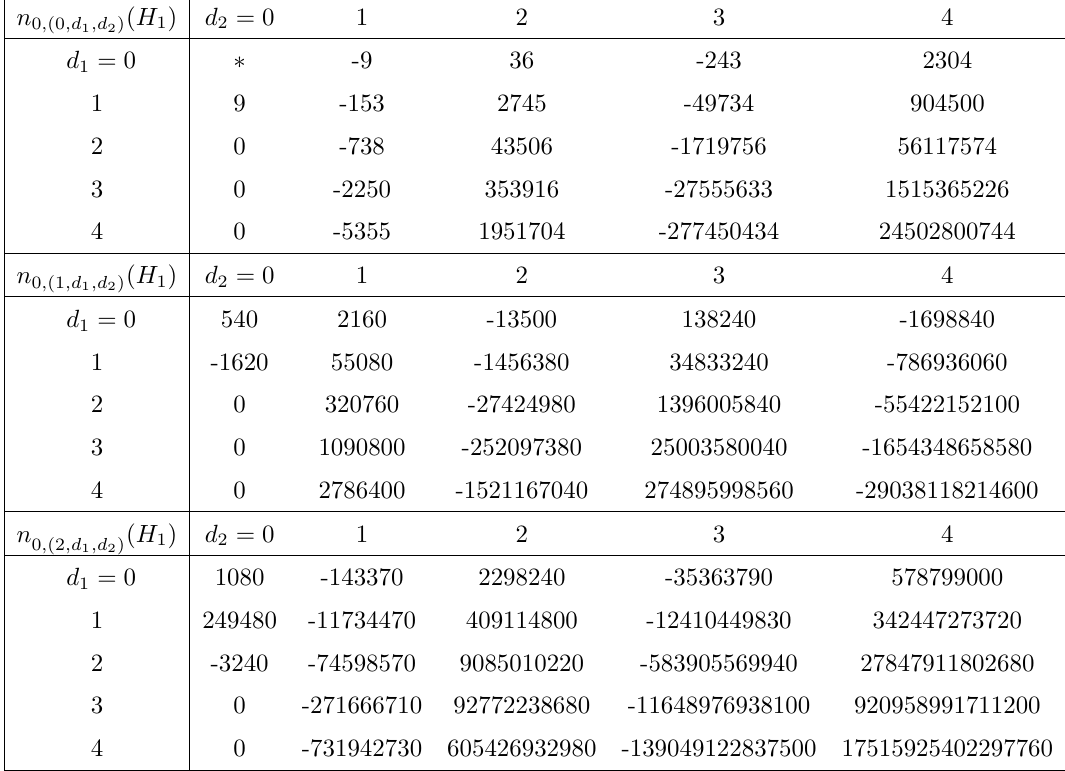
Table 3 . Genus 0 invariants associated to H 1 of M E 8 P 1 × P 2 for degree d e = 0 , 1 , 2 of the elliptic